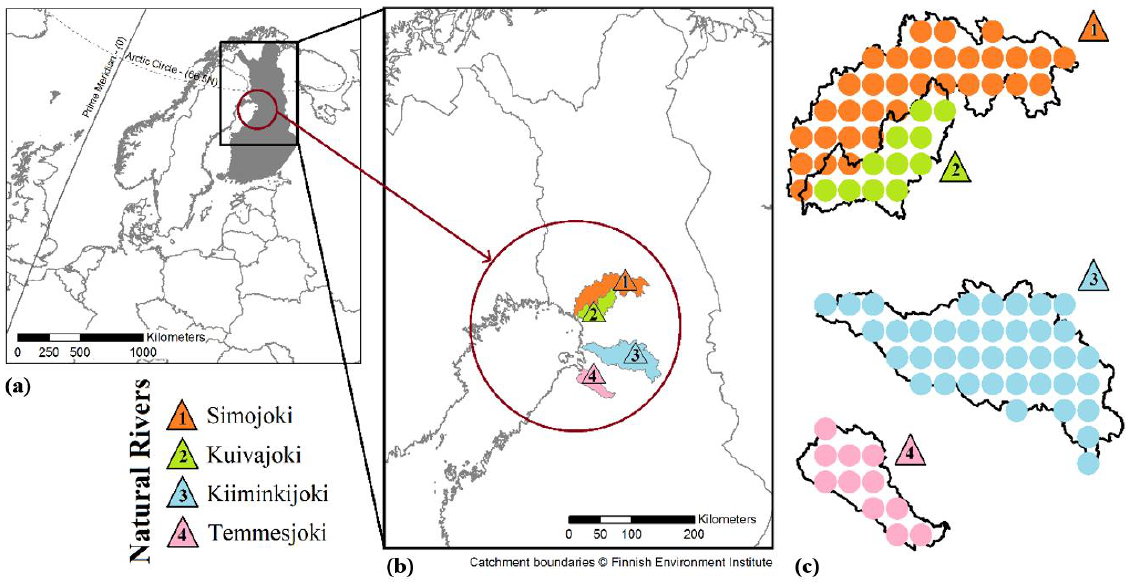
Figure 1. The locations of ( a ) northern Finland, ( b ) four natural rivers selected by this study, and ( c ) 10 × 10 km 2 grid points with precipitation and surface air temperature (SAT) datasets throughout the basins of such natural rivers.